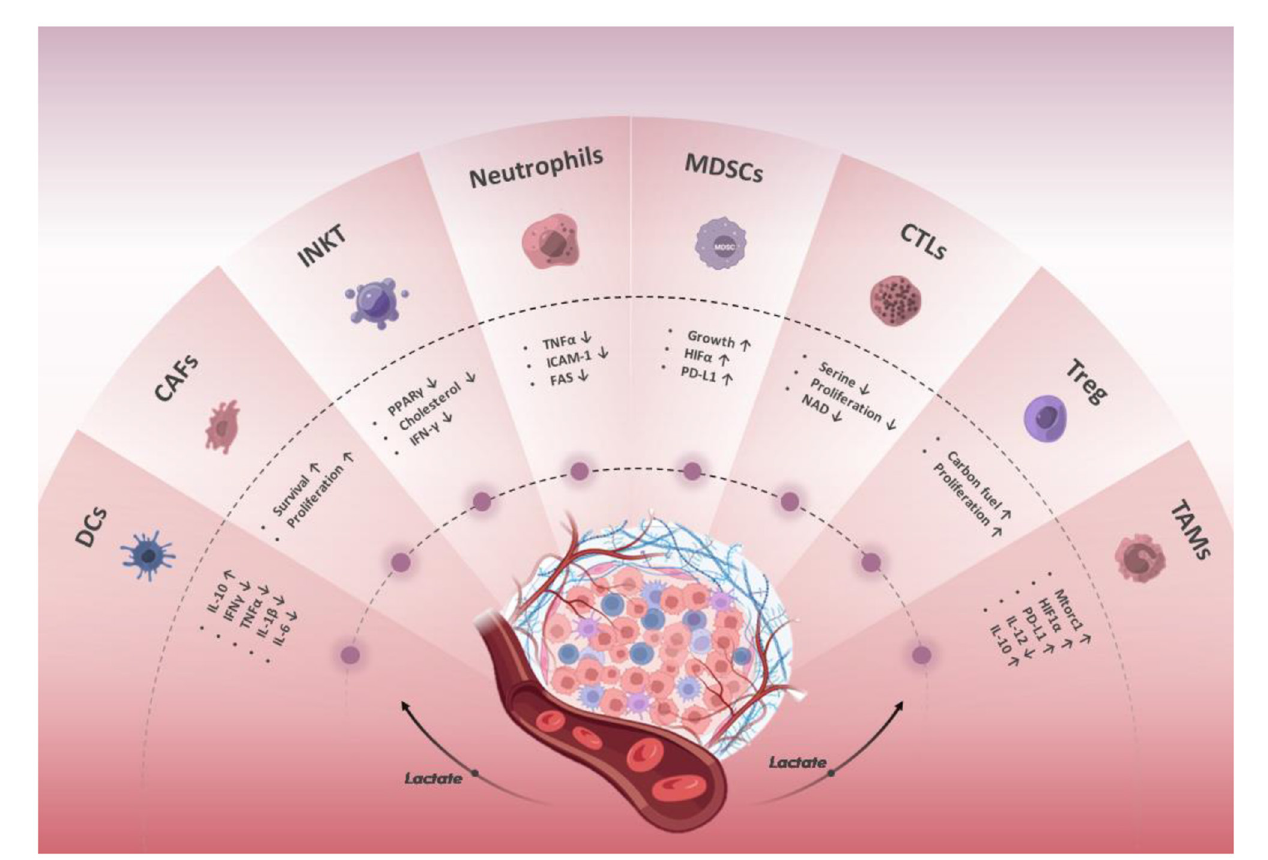
FIGURE2 Effect of lactate in the regulation of the immune response. The lactate in the TME affects the differentiation, metabolism, and function of innate and adaptive tumor-infiltrating immune cells through multiple pathways and inhibits anti-tumor immune responses. The lactate secreted by tumor and stromal cells acidifies the TME and promotes tumor cell proliferation and